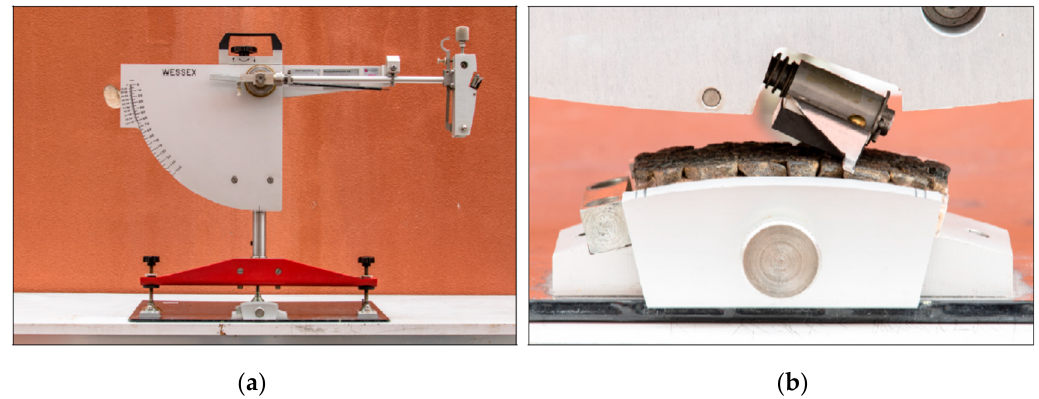
Figure 5. ( a ) British pendulum skid tester; ( b ) specimen block on the base plate.